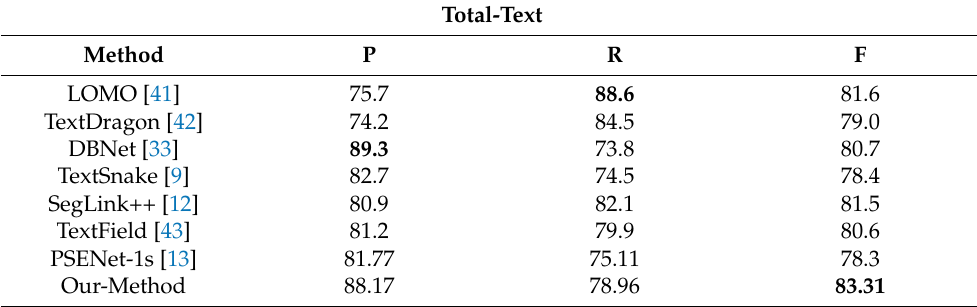
Table 2. The single-scale results on Total-Text. “P”, “R”, and “F” represent the precision, recall, and F-measure, respectively. The best results of all measures are bold.